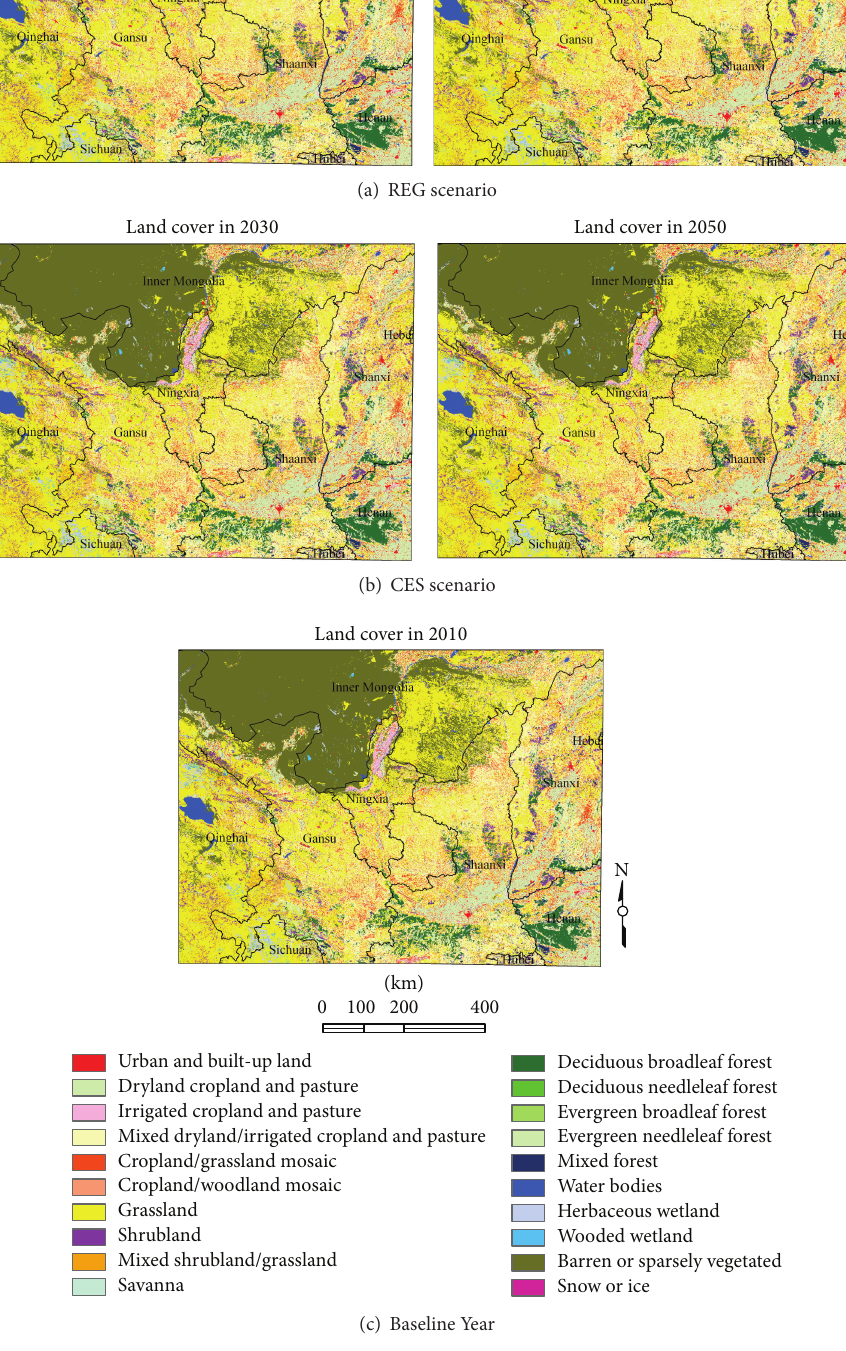
Figure 3: Land cover change under different scenarios from 2010 to